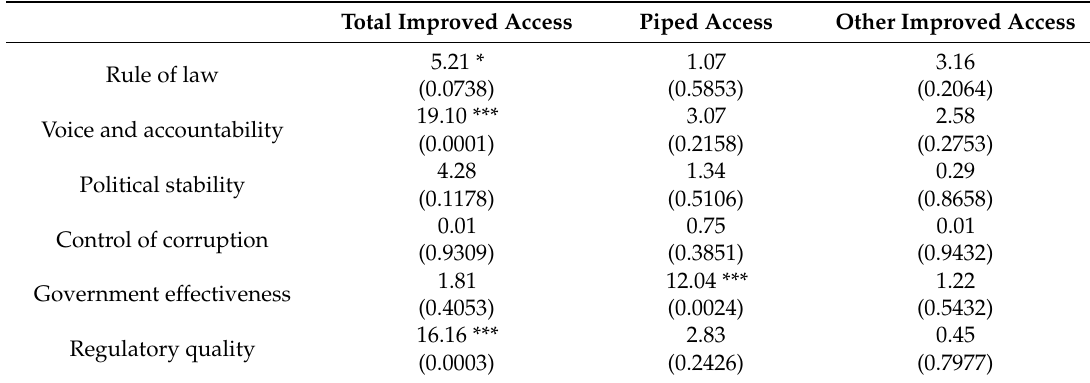
Table A5. Results of Wald test for middle-low income countries. Total Improved